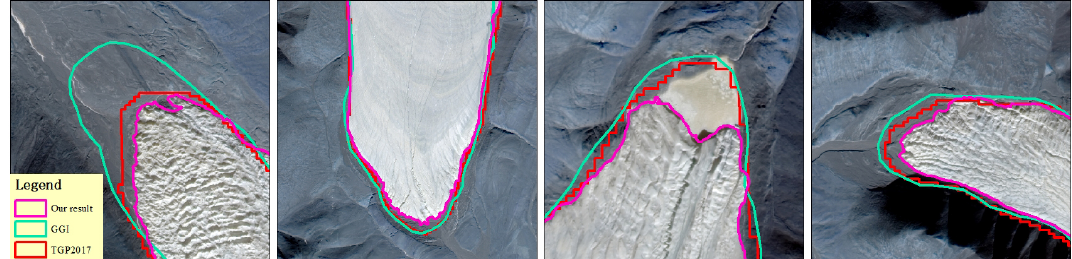
Figure 19. Comparison of different glacier inventories. Our data were obtained in 2020, the GGI was produced in 2002, and the TGP2017 was produced in